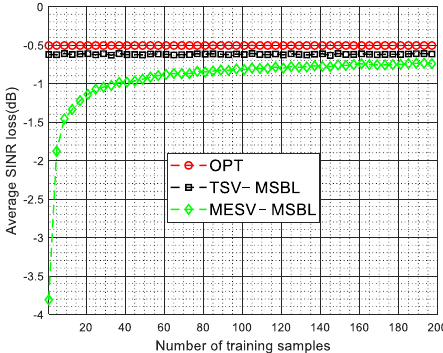
Figure 13. Average SINR loss versus the number of training samples used in the first stage.